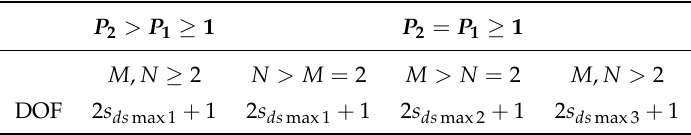
Figure 3. Two examples of the non-negative sum coarray for the CAMpS with ( M , N ) = ( 3,4 ) : ( a ) the set S + cs with ( P 1 , P 2 ) = ( 2,3 ) ; ( b ) the set S + sum with ( P 1 , P 2 ) = ( 2,3 ) ; ( c ) the set S + cs with ( P 1 , P 2 ) = ( 3,3 ) ; and ( d ) the set S + sum with ( P 1 , P 2 ) = ( 3,3 ) . Table 1. The DOFs of the diff–sum coarray for the